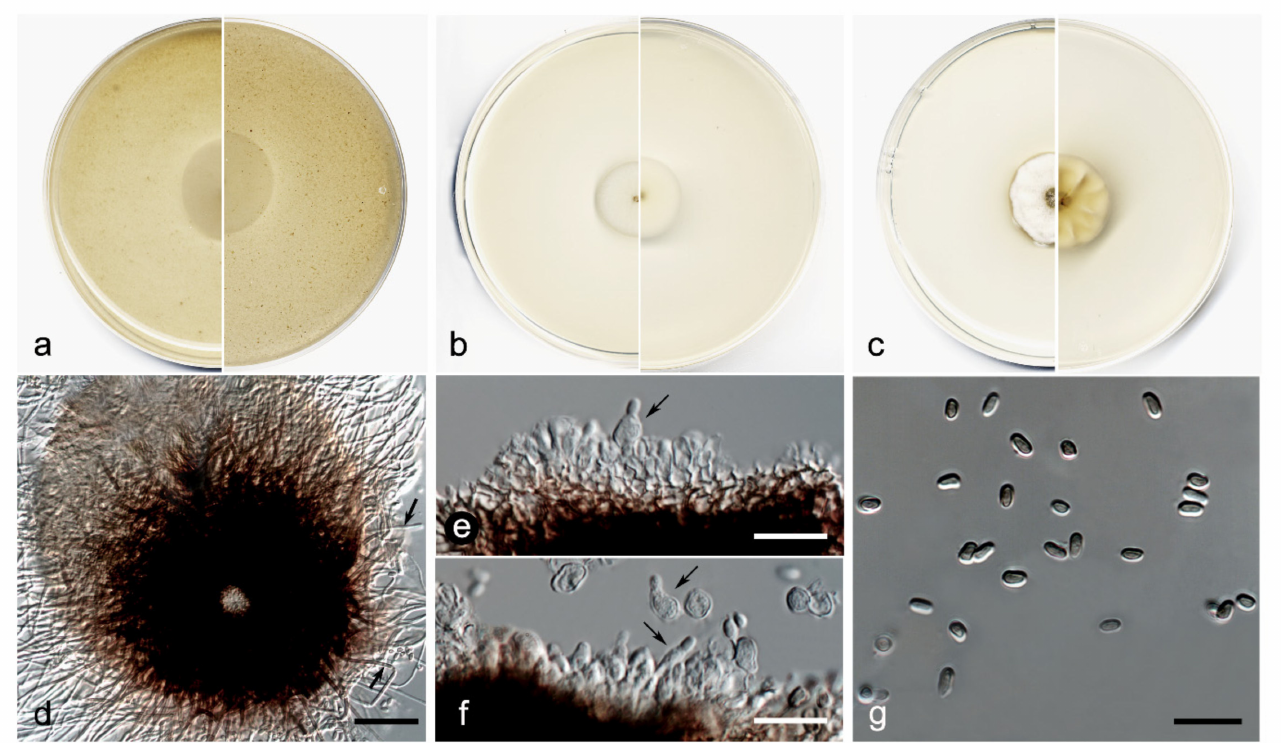
Figure 10. Elongatopedicellata aquatica FMR 17834 ( a ) Colonies on OA ( b ) MEA ( c ) and PDA after two weeks at 25 + 1 ◦ C (surface, left; reverse, right); ( d ) Pycnidium (setae pointed out by black arrows); ( e , f ) Conidiogenous cells (black arrows); ( g ) Conidia. Scale bars: ( d ) = 50 µ m, ( e – g ) = 10 µ